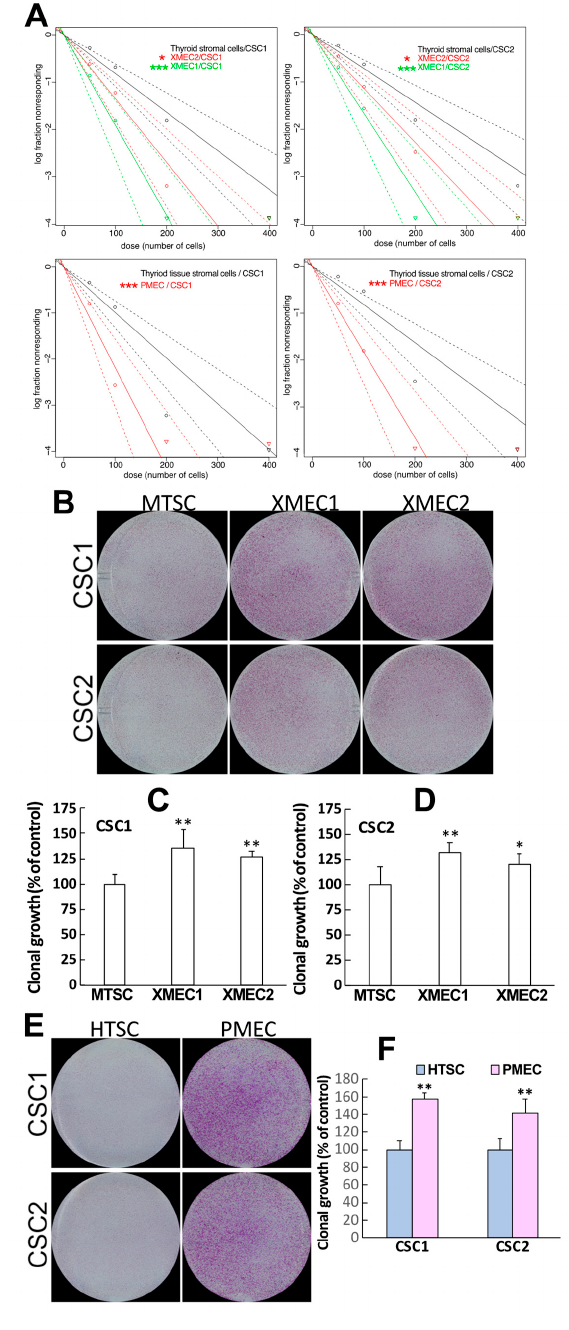
Figure 1. PTC tumor stromal cells enhanced CSC self-renewal and clonal growth . A Tumor stromal cell increased CSC sphere formation efficiencies in transwell cocultures as the stromal cells isolated from either patient-derived xenograft tumors (top panel) or patient primary tumors (bottom panel). B-F Tumor stromal cells enhanced CSC clonal growth in transwell cocultures as the stromal cells isolated from either patient- derived xenograft tumors (B-D) or patient primary tumors (E and F). Data are representative of at least three independent experiments and shown as mean ± SEM. Mouse normal thyroid stromal cell culture (MTSC), xenograft tumor microenvironment stromal cell culture (XMEC), patient non-tumor thyroid stromal cell culture (HTSC), patient primary tumor microenvironment stromal cell culture (PMEC); *p<0.05, **p<0.01,